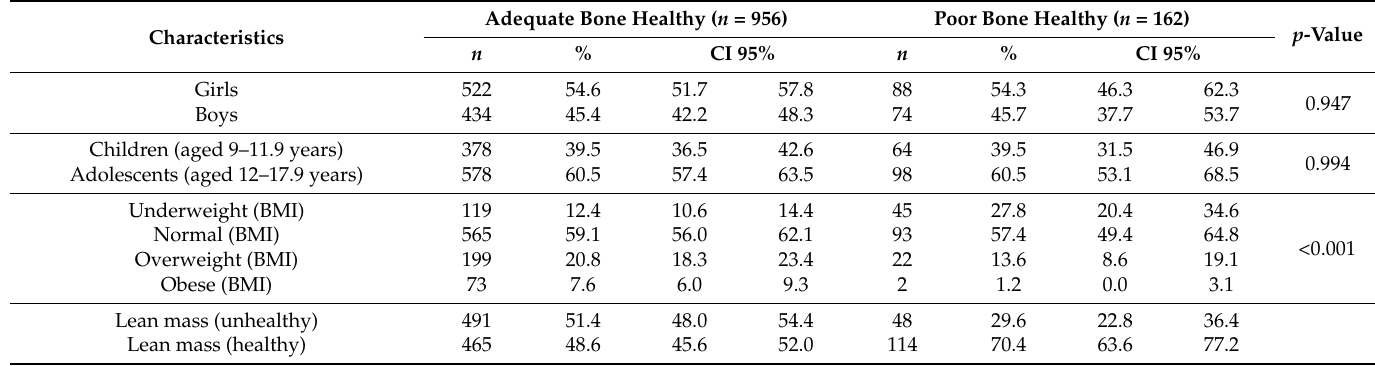
Table 3. Prevalence and anthropometric, body composition, muscular fitness and nutritional profile characteristics associated with healthy and poor